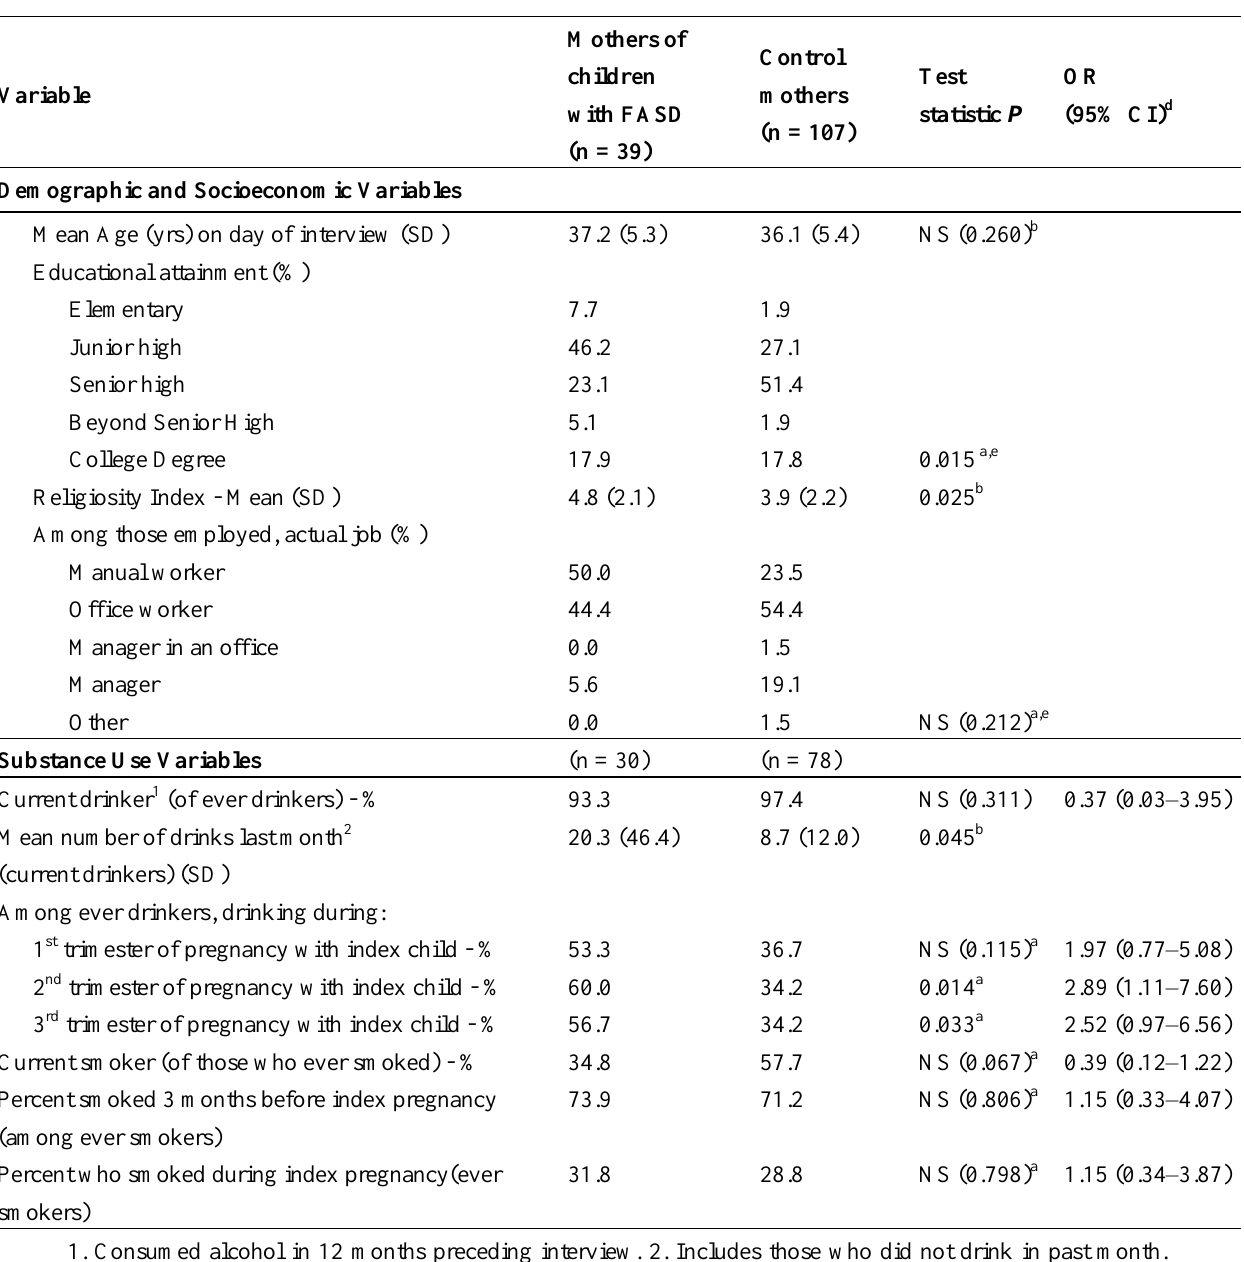
Table 3. Demographic, socioeconomic, and maternity variables and substance use measures by mothers of the children with FASD and randomly selected controls: Lazio Region,